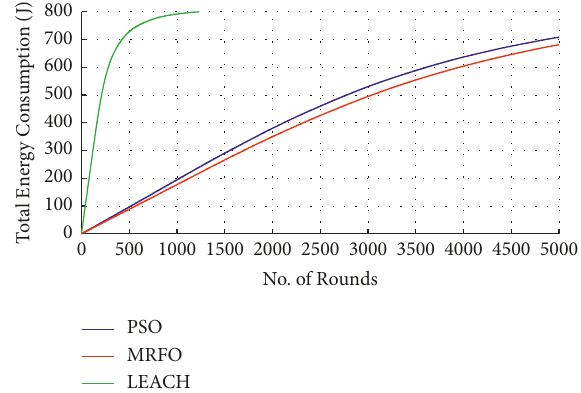
Figure 14: Total energy consumption for 400-node network, 40 CHs when the BS is at the outside the ROI.